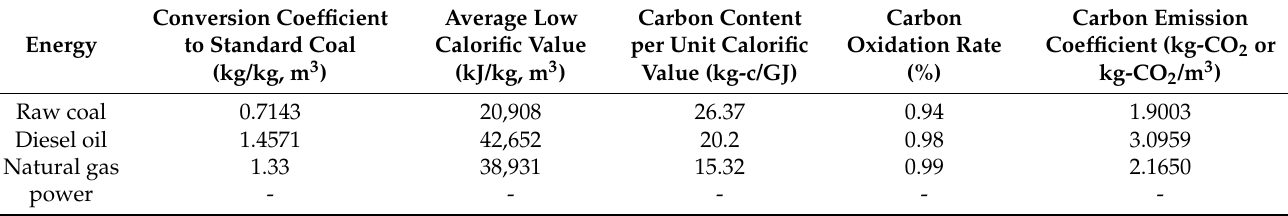
Table 5. Carbon emission coefficient of transportation